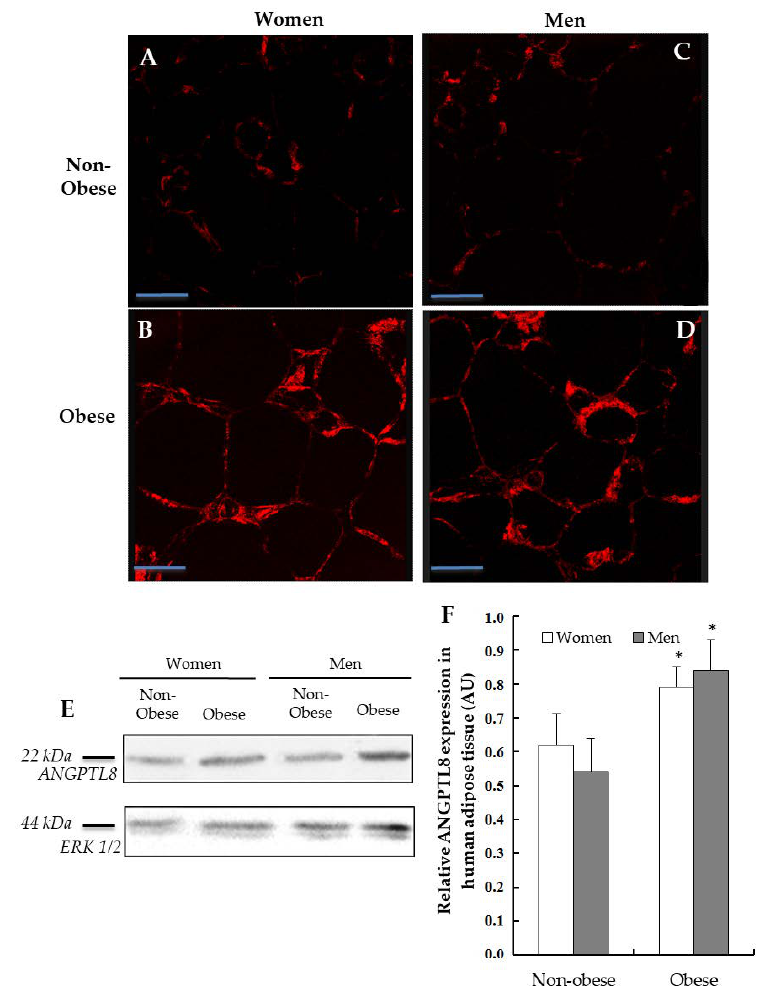
Figure 2. Detection of ANGPTL8 in human visceral adipose tissue (VAT). Representative images from the immunofluorescence reaction for positive ANGPTL8 (in red) in adipose cells of patients, ( A , non-obese women, n = 4), ( B , obese women, n = 4), ( C , non-obese men, n = 4), ( D , obese men, n = 4). Scale bar: 60 µ m. ( E ) Western blotting analysing the expression of ANGPTL8 in human VAT ( n = 6), ERK1 / 2 was used to confirm equal loading of samples. ( F ) Plot showing the relative ANGPTL8 expression as arbitrary units